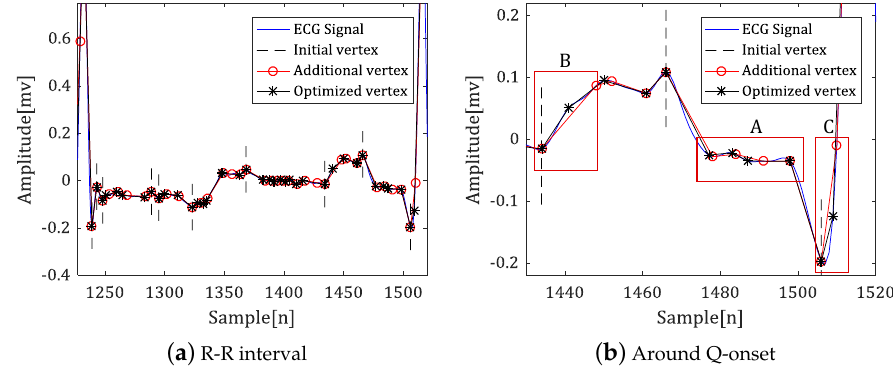
Figure 4. Additional vertex calibration results using dynamic